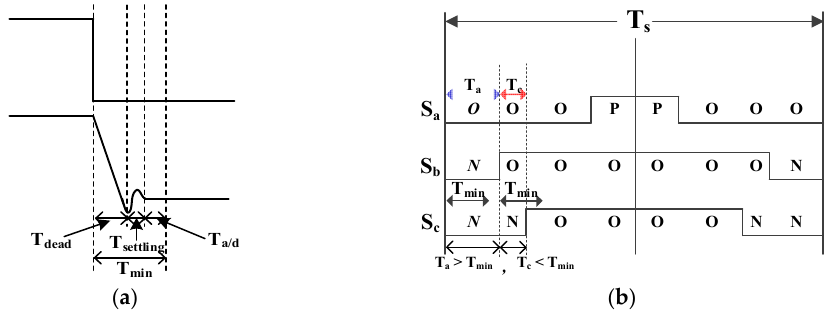
Figure 6. T min and T s of the SVPWM method. ( a ) Minimum time ( T min ); ( b ) one PWM period ( T s ).